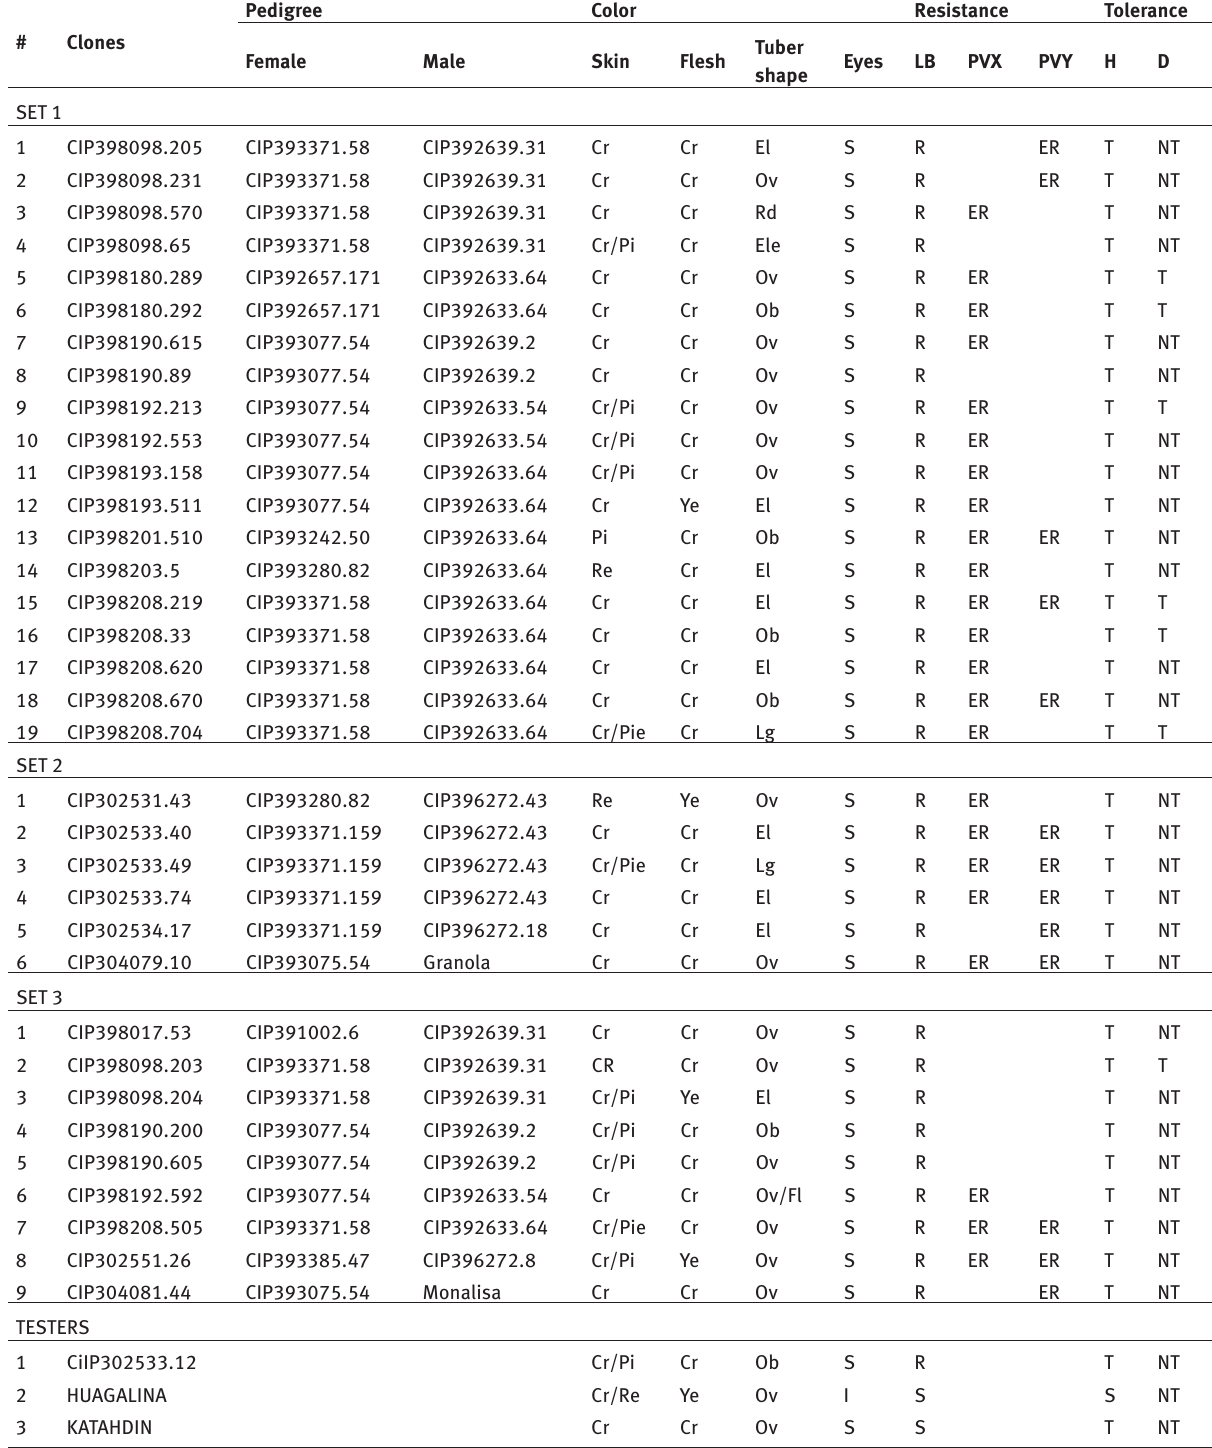
Table 1: Characteristics of Advanced Potato clones from LBHT